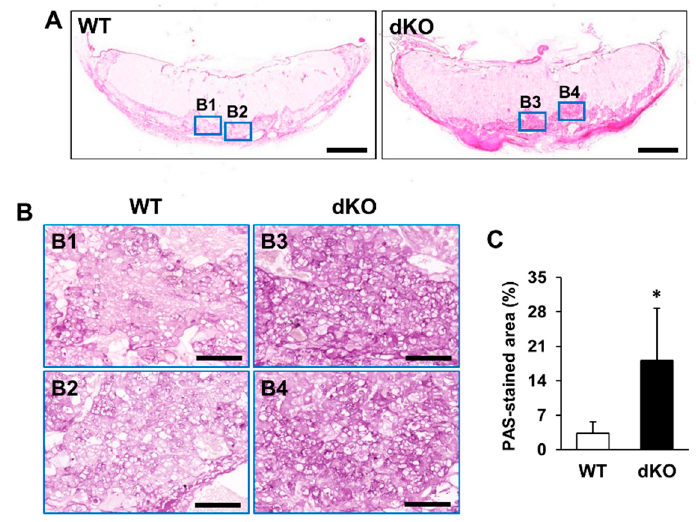
Figure 6. Histological analysis of WT and Stab1 / 2 dKO placentas based on PAS staining. ( A ) Overall shape of the PAS-stained placentas derived from WT and Stab1 / 2 dKO mice. Scale bar, 1 mm. ( B1 – B4 ) High-magnification images of the blue rectangles in ( A ). Scale bar, 100 µ m. ( C ) Percentage of PAS-stained positive area to the total tissue area was analyzed using ImageJ. *, p < 0.05 versus WT; n = 3.